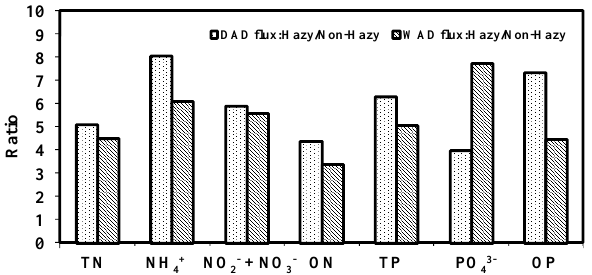
Fig. 7. Ratio of hazy to non-hazy days fluxes of N and P species in DAD and WAD during 2006 haze episodes,